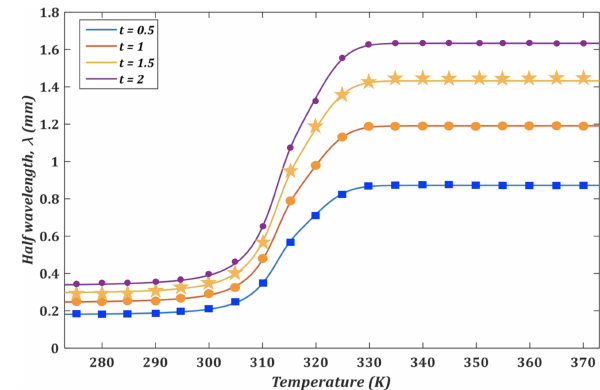
Figure 13: Variation of the half fiber buckling wavelength ( λ ) with respect to temperature ( T ) at V f from 20 to 70%